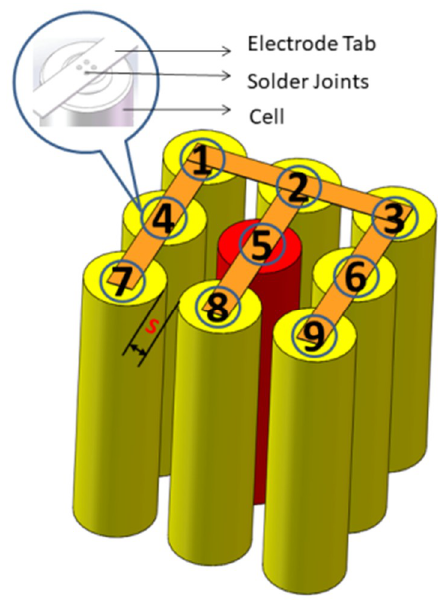
Figure 1. Battery module structure with M-type tab.